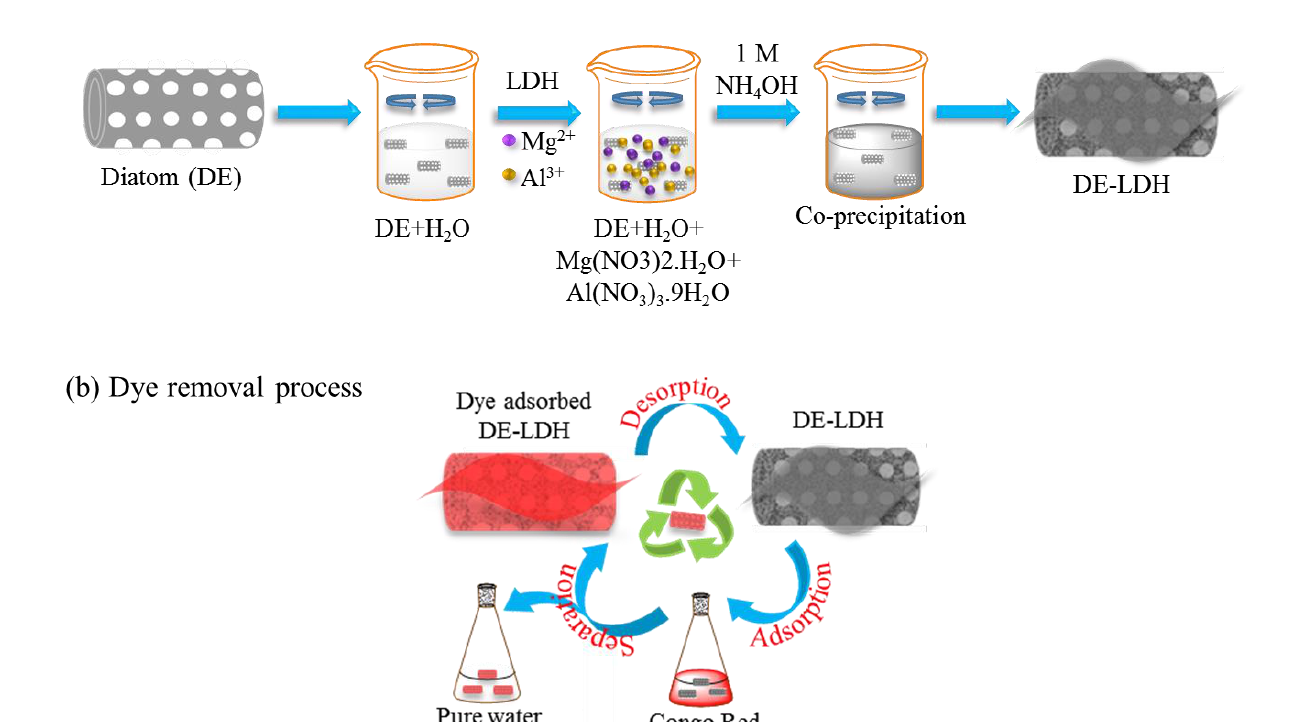
Figure 1. Schematic illustration for the synthesis of diatomaceous earth Mg–Al-layered double hydroxide (DE-LDH) (a) and its application in Congo Red (CR) removal (b).